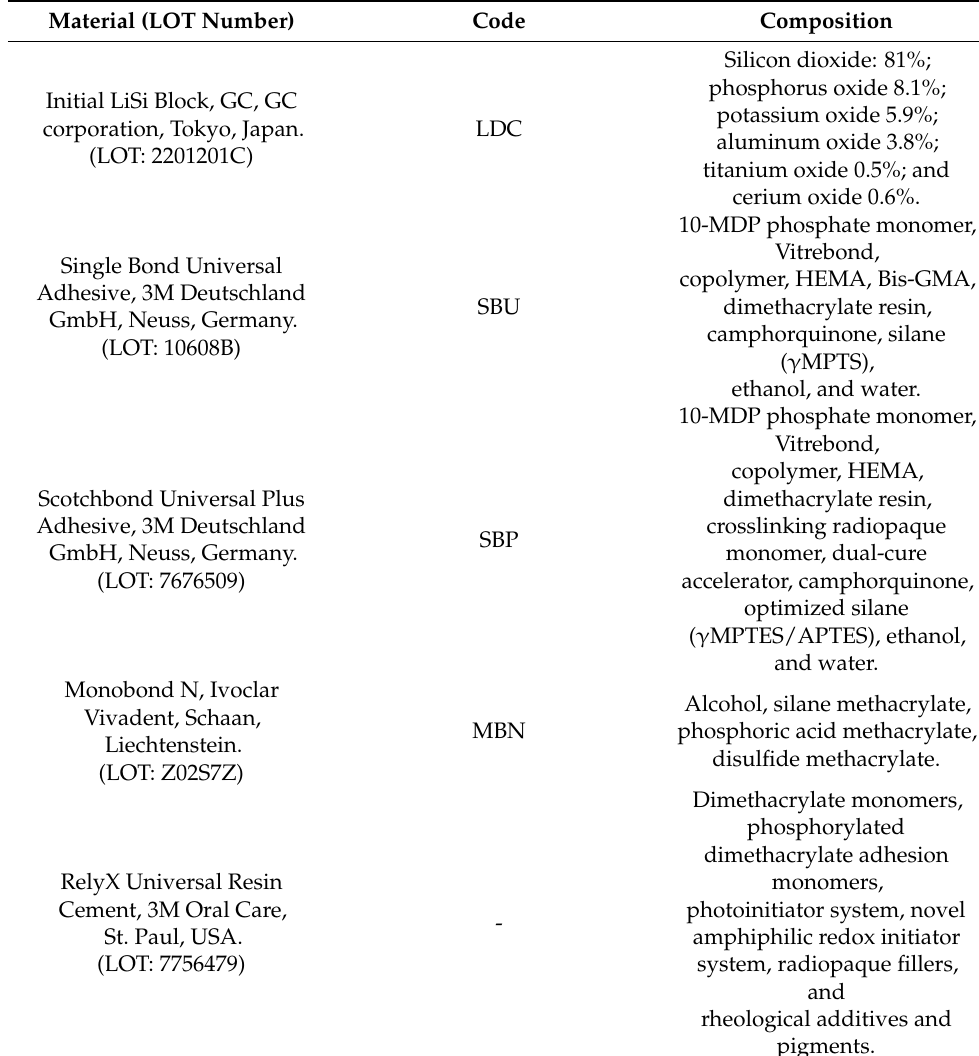
Table 1. Materials used in